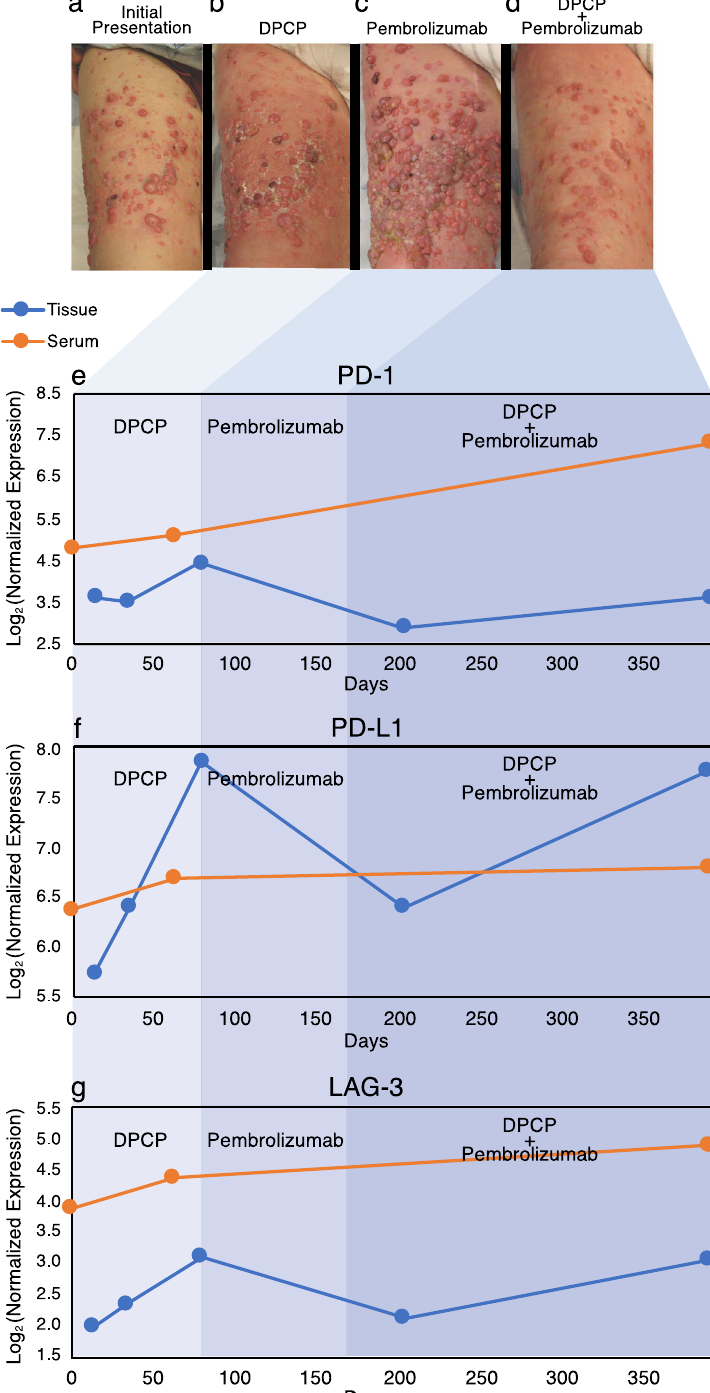
Figure 1. Responses of cutaneous melanoma metastases to topical DPCP, pembrolizumab, and a combination of both treatments. A photograph of the patient’s right anterior thigh before any treatment shows numerous amelanotic cutaneous melanoma metastases ( a ). Topical DPCP monotherapy ( b ) led to a mixed tumor response. During pembrolizumab monotherapy ( c ) there was rapid progression of disease. During dual therapy with pembrolizumab and DPCP, dramatic regression of cutaneous melanoma metastases was observed. Panels a – d adapted from Gulati et al. 4 © 2016 John Wiley & Sons A/S. Published by John Wiley & Sons Ltd. Line plots of protein levels in serum and tissue of immune checkpoint markers PD-1 ( e ), PD-L1 ( f ), and LAG-3 ( g ) are shown correlating with the various phases of the patient’s treatment